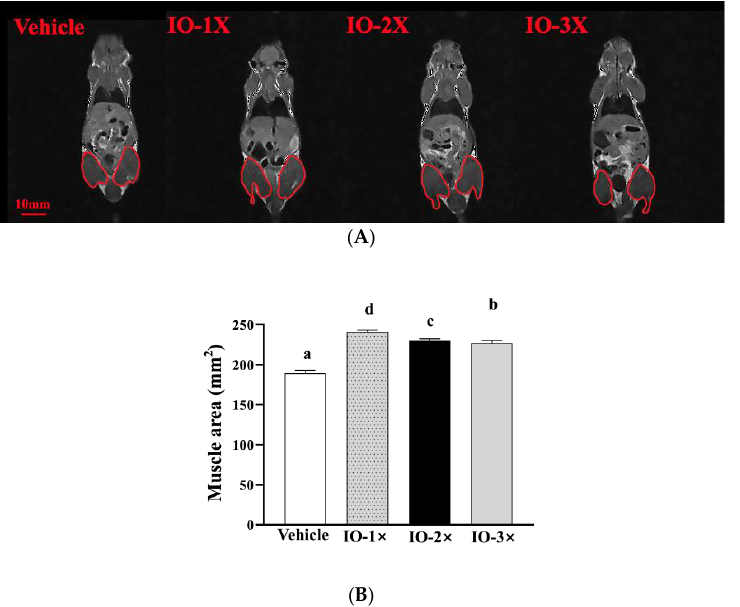
Figure 2. Effect of IO on the magnetic resonance imaging ( A ) of mouse muscle volume and major organ diagnostics ( B ). Different letters (a, b, c, d) indicate a significant difference at p <